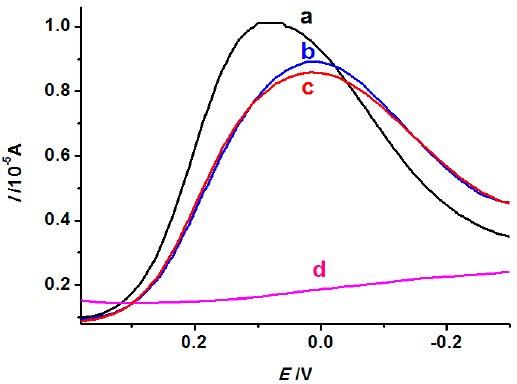
Figure 8. DPV responses of the INS to different concentration of TBP ( a : 1.0 × 10 − 7 ; b : 1.0 × 10 − 5 ; c : 1.0 × 10 − 3 mol·L − 1 and NINS to 1.0 × 10 − 5 mol·L − 1 TBP ( d )).